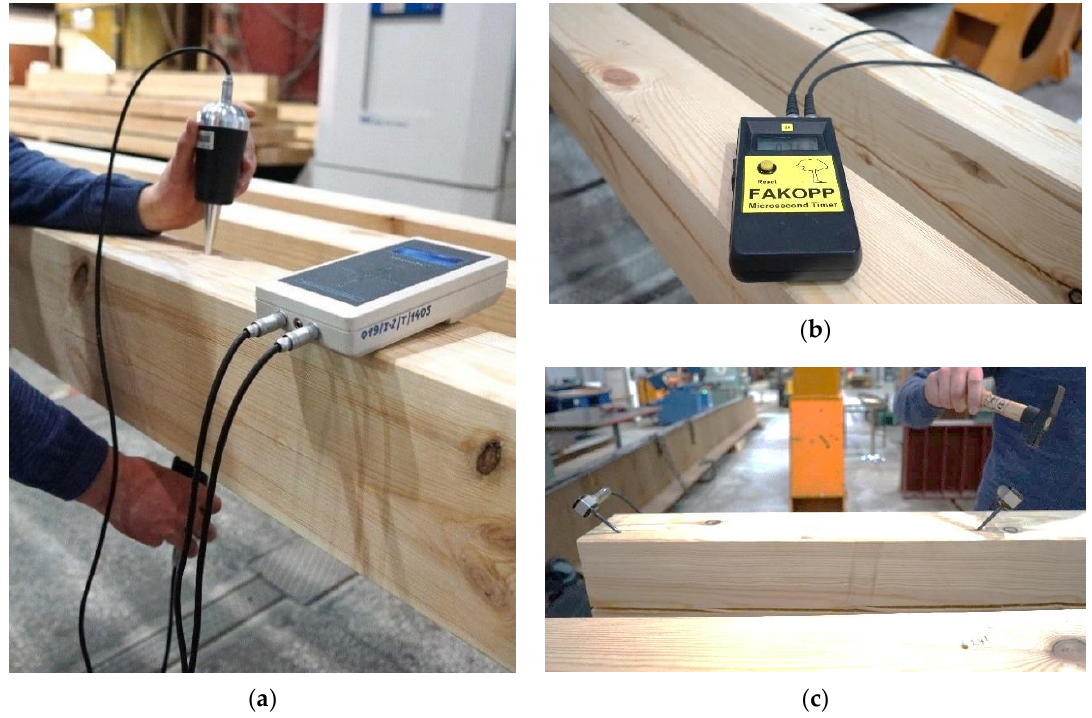
Figure 2. Determination of the dynamic modulus of elasticity using the acoustic method: ( a ) testing with the Sylvatest Trio device, ( b , c ) testing with the Fakopp MS device